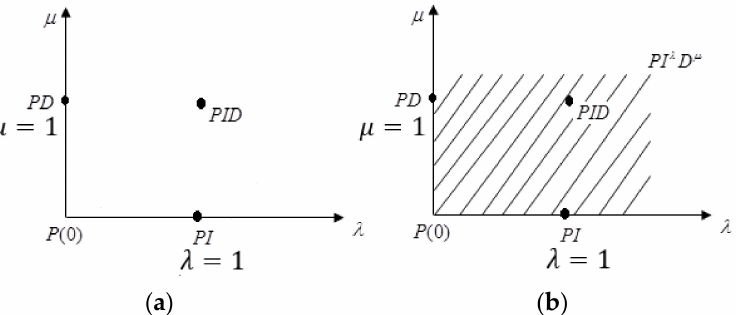
Figure 3. PID controller and FO PI λ D µ controller: ( a ) PID controller and ( b ) FO PI λ D µ